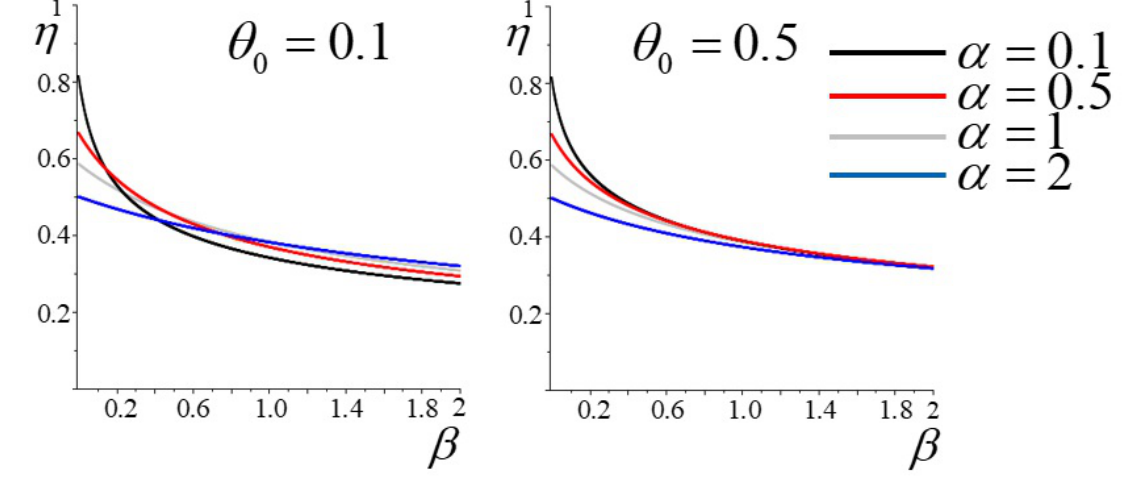
Figure 6. The plot of classical efficiency η (from [4]) as a function of β for θ 0 = 0.1 and θ 0 = 0.5 and four different values of α